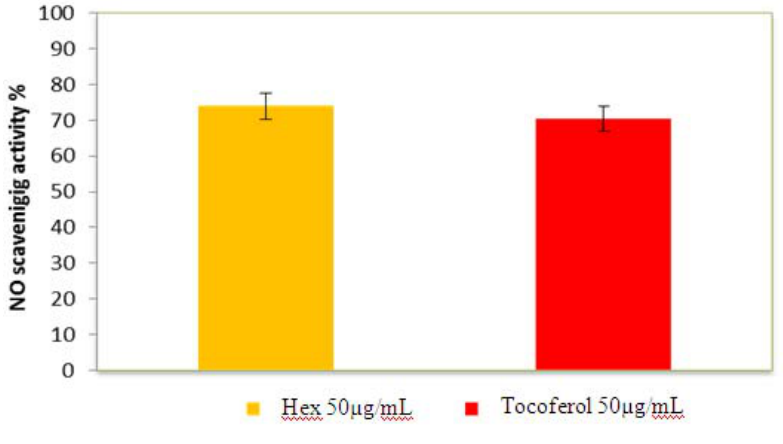
Figure 5. Nitric oxide radical scavenging activity of HS and α -tocoferol. Values are mean ± SEM and significantly p <